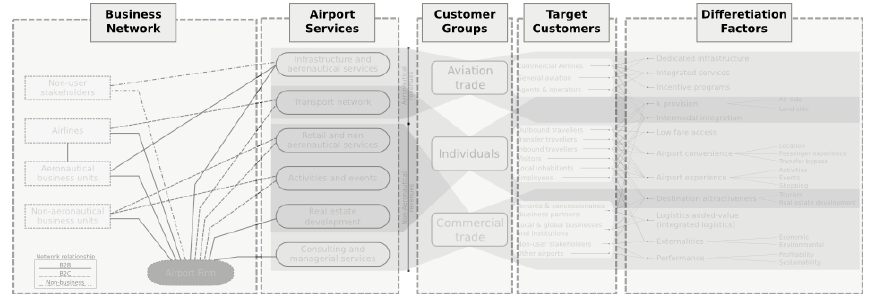
Figure 5 – Integrated framework for the assessment of airport differentiation